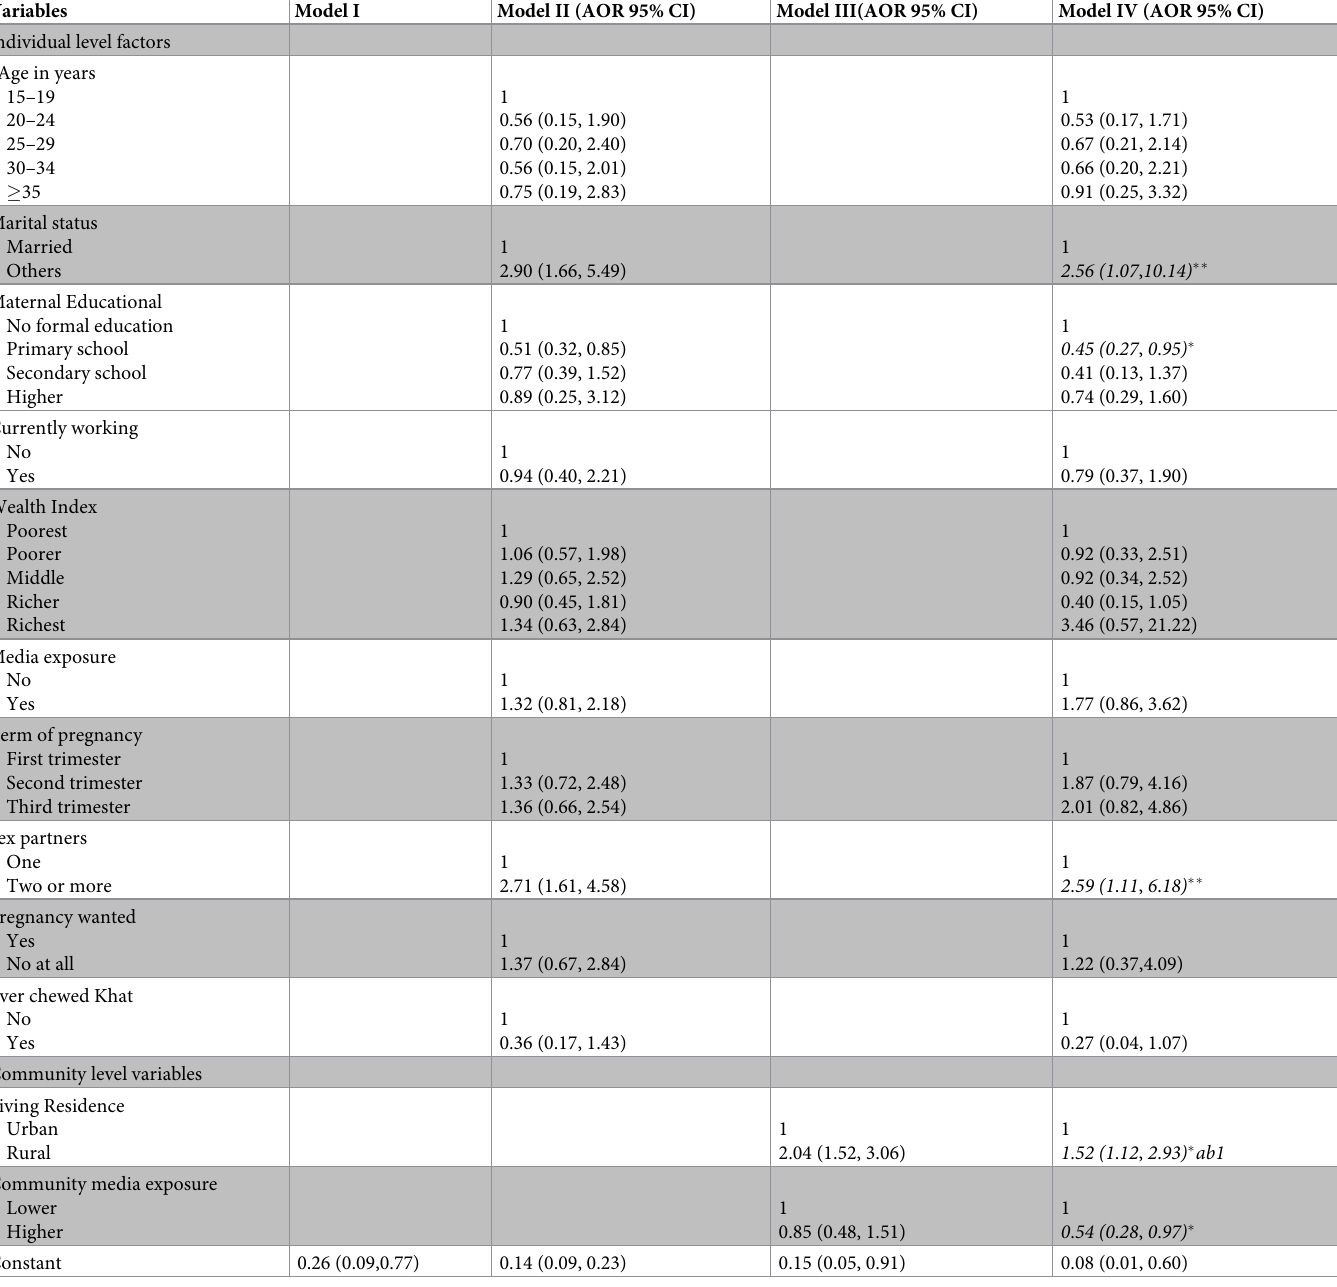
Table 4. Multivariable multilevel logistic regression analysis result of the individual and community level determinants of alcohol consumption among pregnant women in Ethiopia,